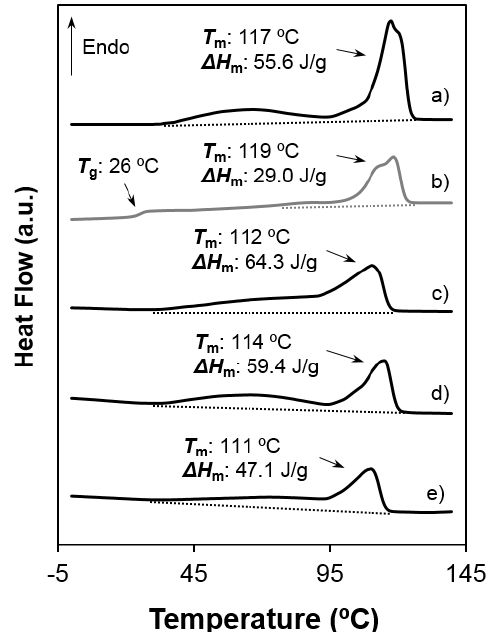
Figure 6. Heating scans of different poly(glc-5-glc 6) samples: ( a ) as-synthesized powder; ( b ) film prepared from solvent casting of a 1,1,1,3,3,3-hexafluoroisopropanol solution and ( c ) electrospun scaffold. Melting enthalpies are given for the overall set of endothermic transitions.